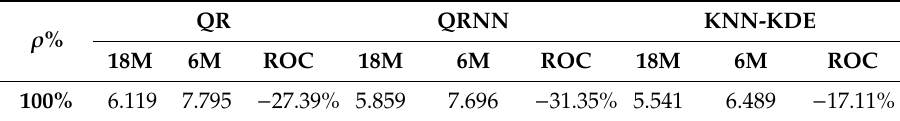
Table 5. QS values of three probabilistic forecasting models trained by di ff erent numbers of training